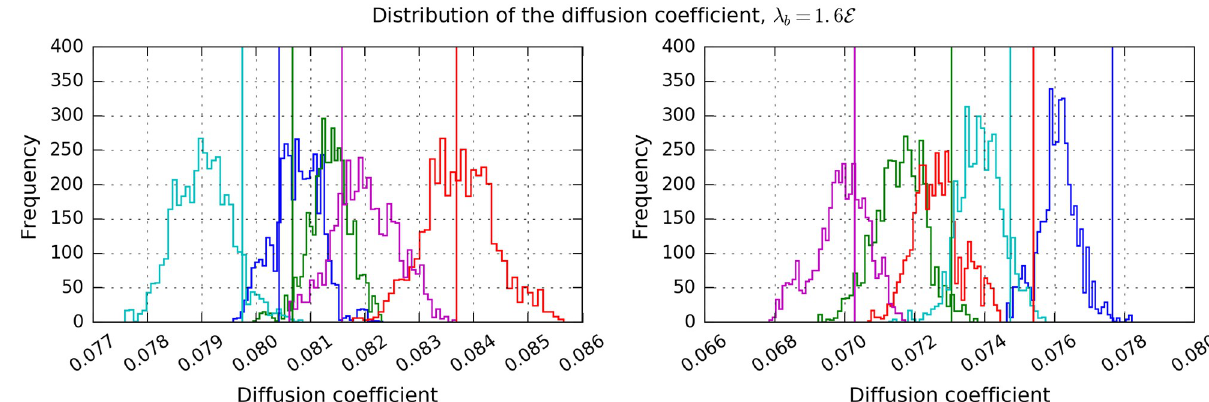
Fig 7. The distribution of diffusion coefficient, D , calculated from the Biggles samples. Each panel shows the result from a single GT simulation, i.e simulated particle states governed by birth rate and the survival probability. From each GT ten GTR have been created, governed by the observation rate, the observation error and the clutter rate. The ground truth D = 0.08, D calculated from the GTR is shown as vertical, dashed lines whose colours correspond to the colour of the histograms. The two numbers indicate how often the GTR D lies within 1 σ and 2 σ of the sample average of the respective Biggles output. Since there are 10 GTR per panel, possible values are multiples of